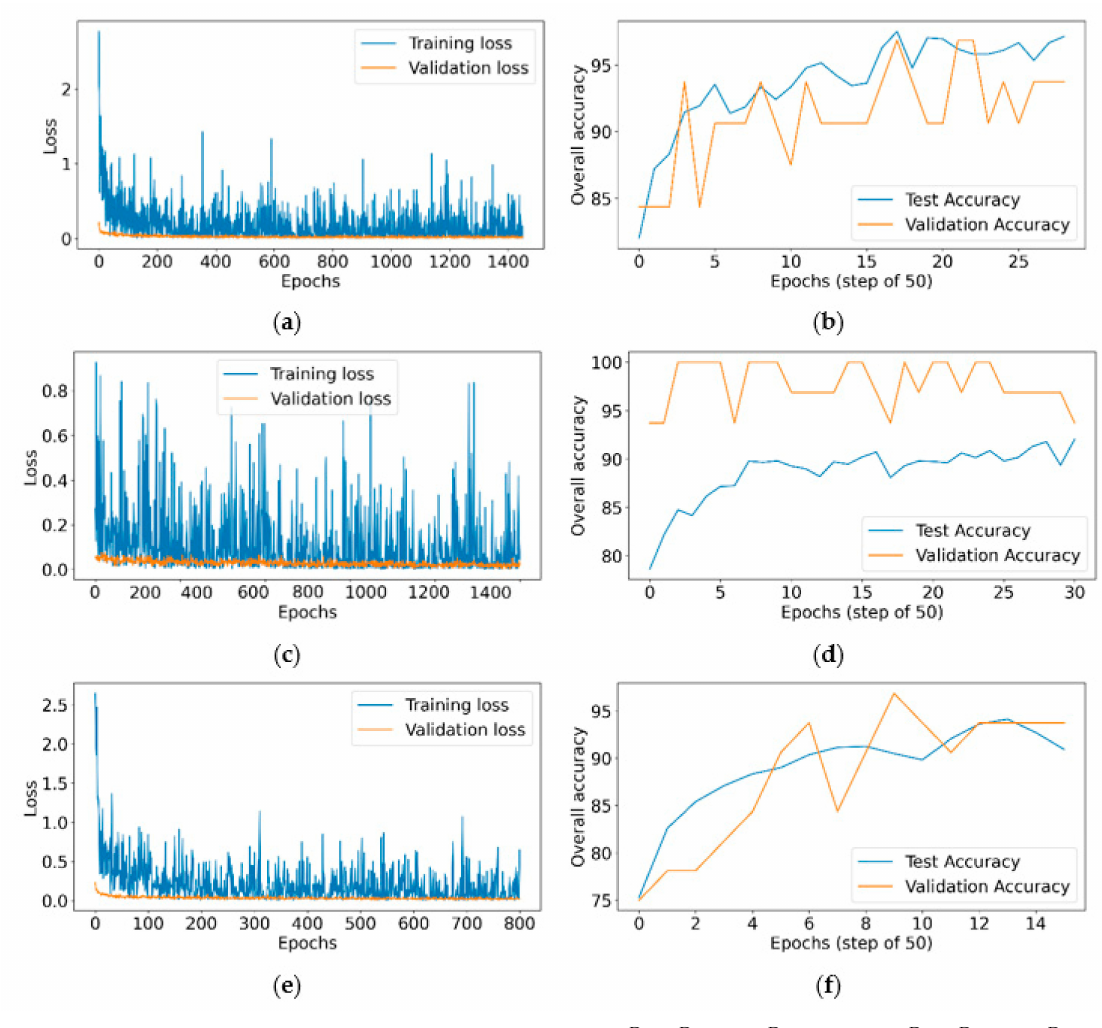
Figure 6. Loss and accuracy curves from Table 4 experiments: ( a ) (cid:8) A D , M D ( c )